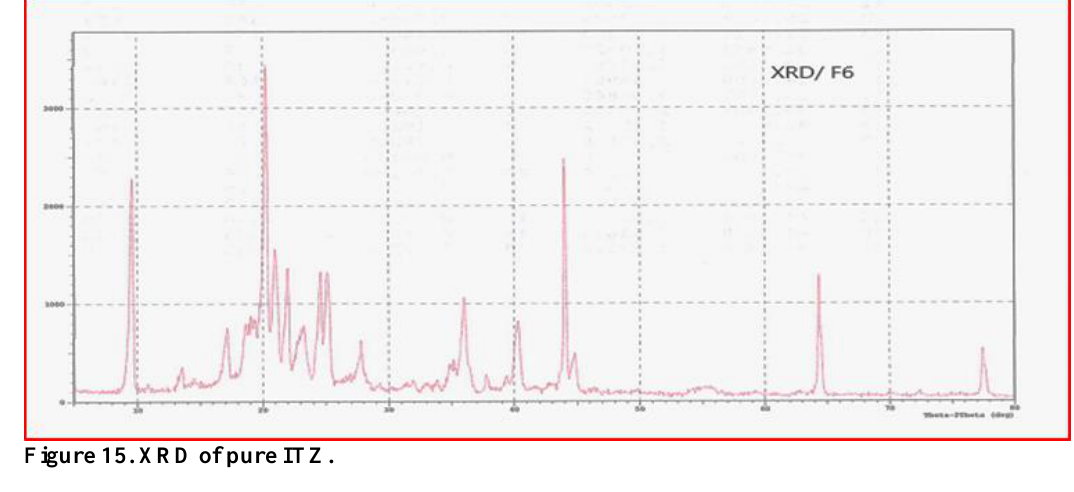
Figure 15. XRD of pure ITZ.